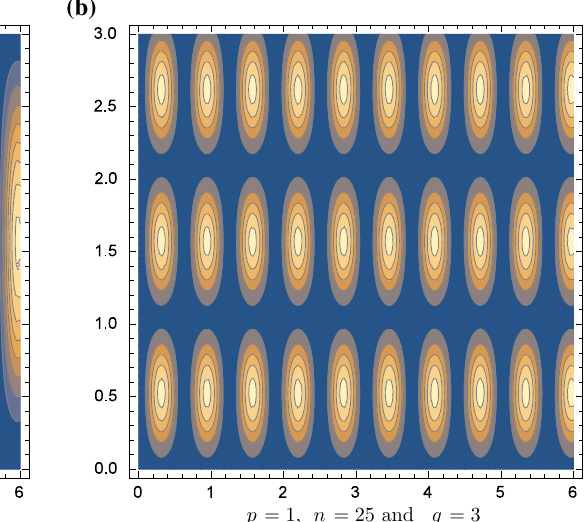
The patterns of the peaks clearly show a crystal-like structure. It is clear to see that, when passing from q = 1 to higher values of q (keeping fixed n and p ), the bumps in the energy density (which, when q = 1, carry one unit of Baryon charge) are divided into q smaller bumps each of which carries 1 / q of Baryon charge. a p = 1, n = 25 and q = 1. b p = 1, n = 25 and q =